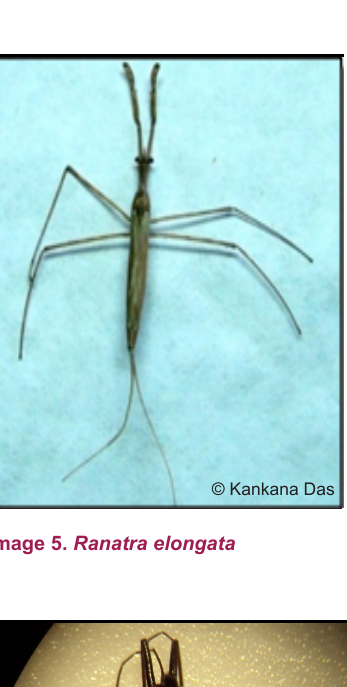
Image 2. Micronecta scutellaris scutellaris